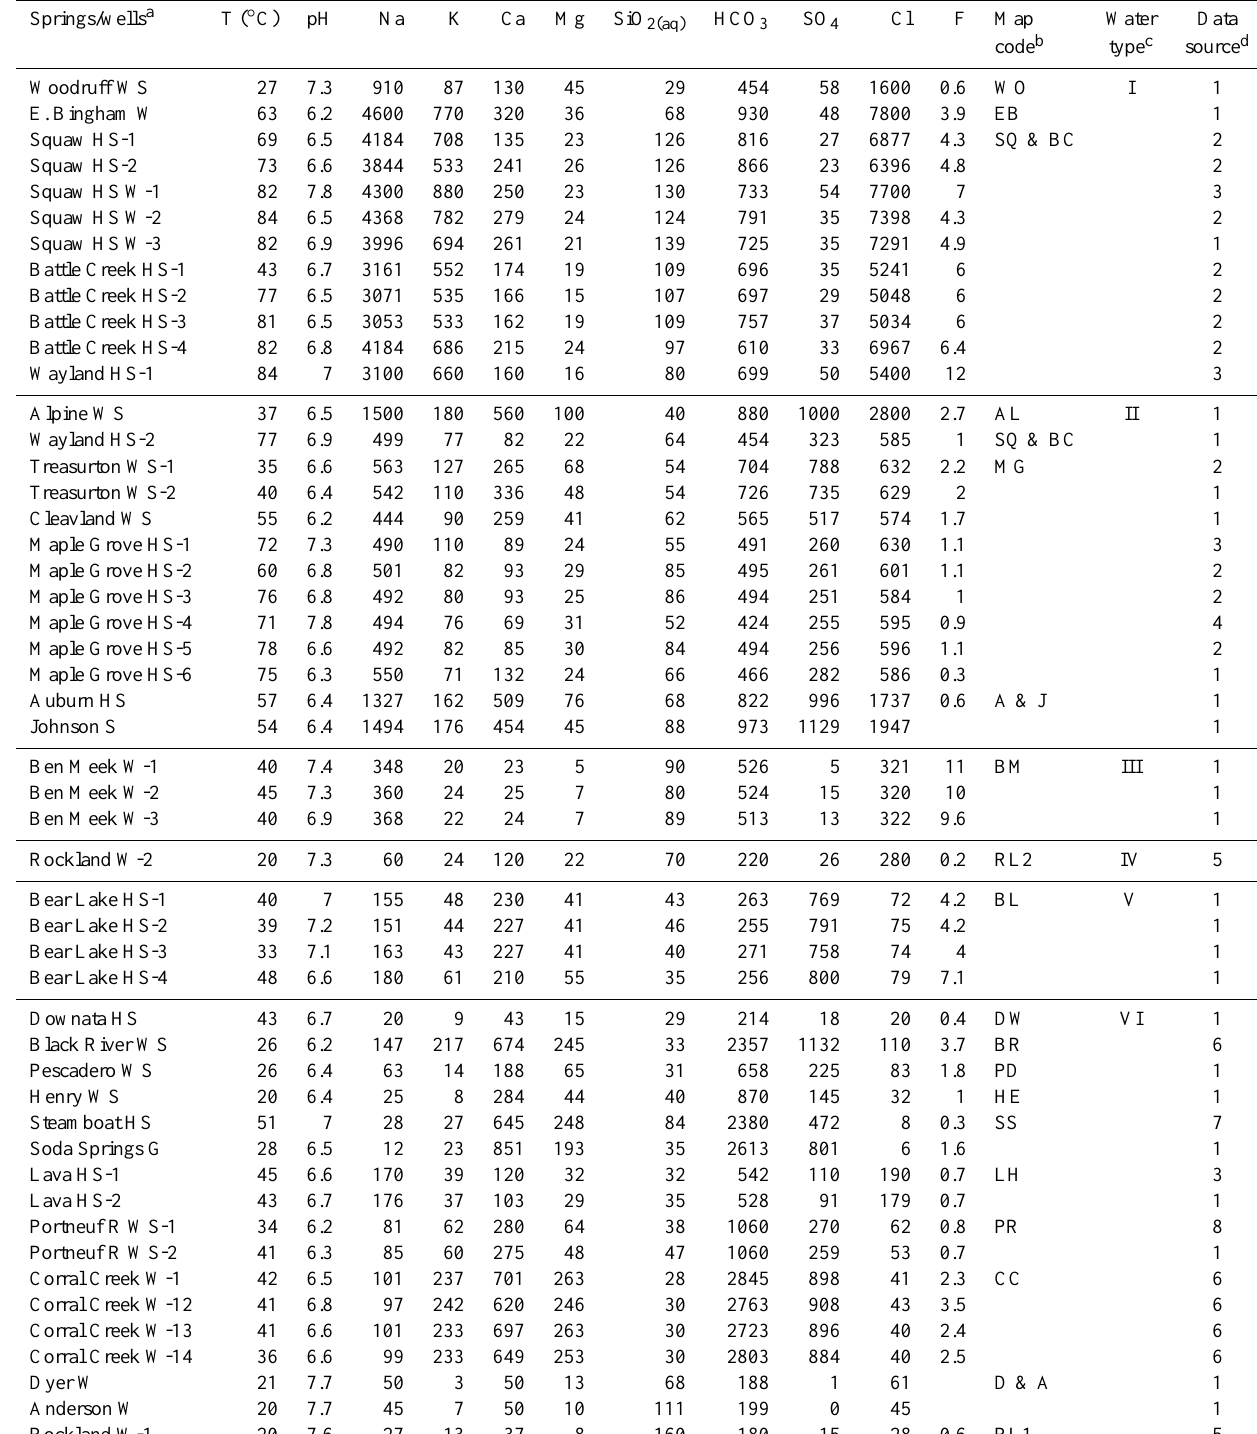
Table 2. Water compositions of selected hot/warm springs and wells in southeastern Idaho used for temperature estimation. Elemental/species concentrations are given in mgL − 1 . The pH was measured in the